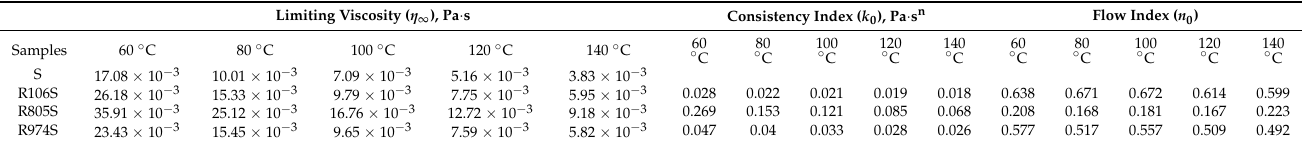
Table 5. Parameters of the Sisko model for the HFS suspensions studied.